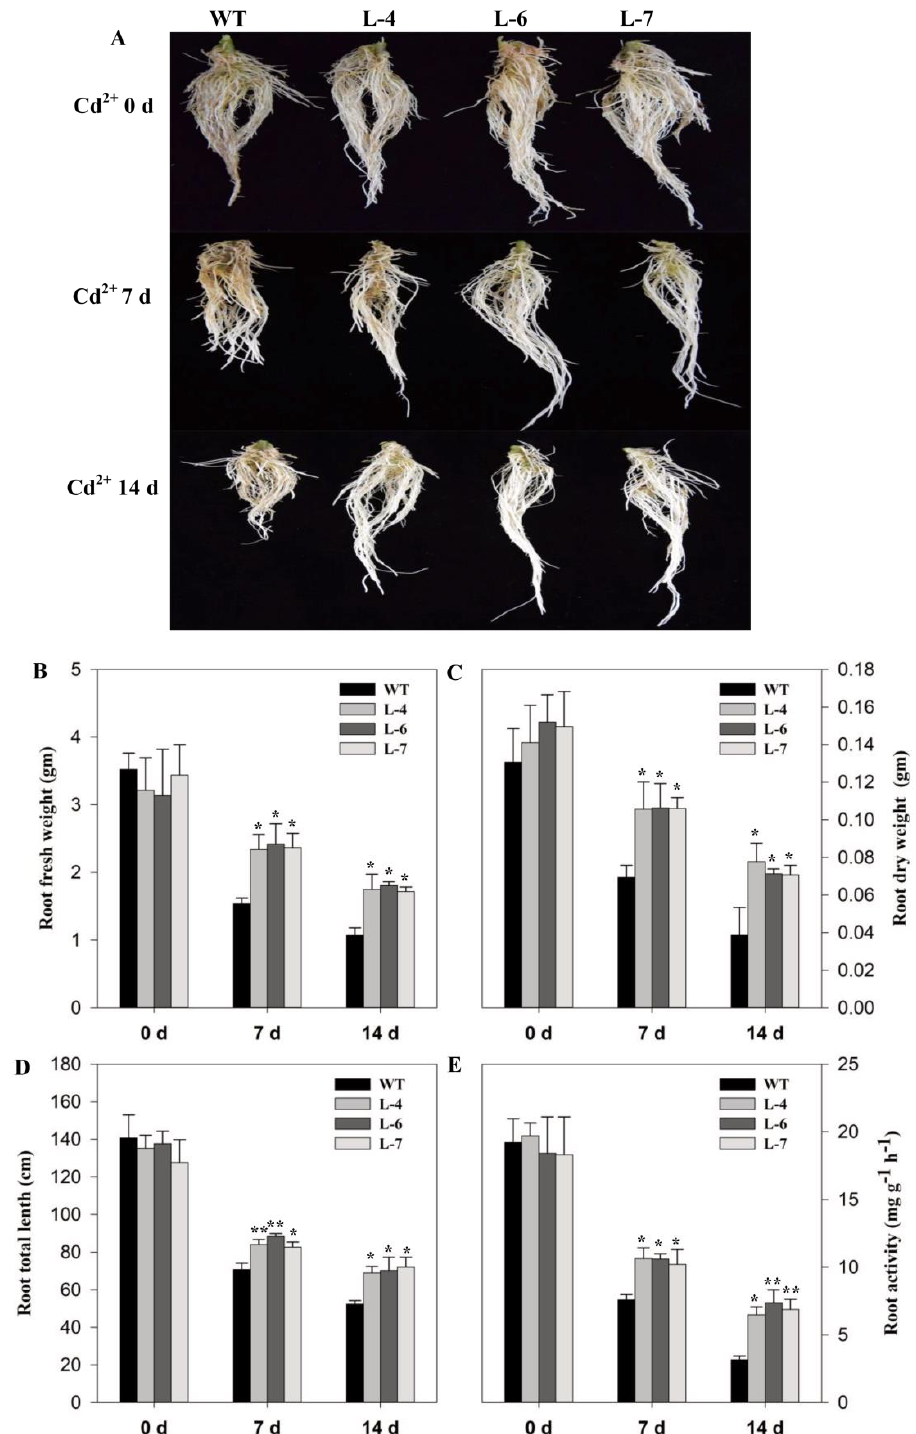
Figure 5. Overexpression of SlMAPK3 improved root morphology under cadmium stress in tomato. ( A ) Roots phenotype, ( B ) root fresh weight, ( C ) root dry weight, ( D ) root total length, and ( E ) root activity. Seedlings of WT and transgenic lines at five leaf-stage were treated with 0 (0 days) and 100 µM (7- and 14-days) cadmium. For B – E , data represent mean ± SE of three biological replicates. **, * significant level differed at p < 0.01 and p < 0.05, respectively.